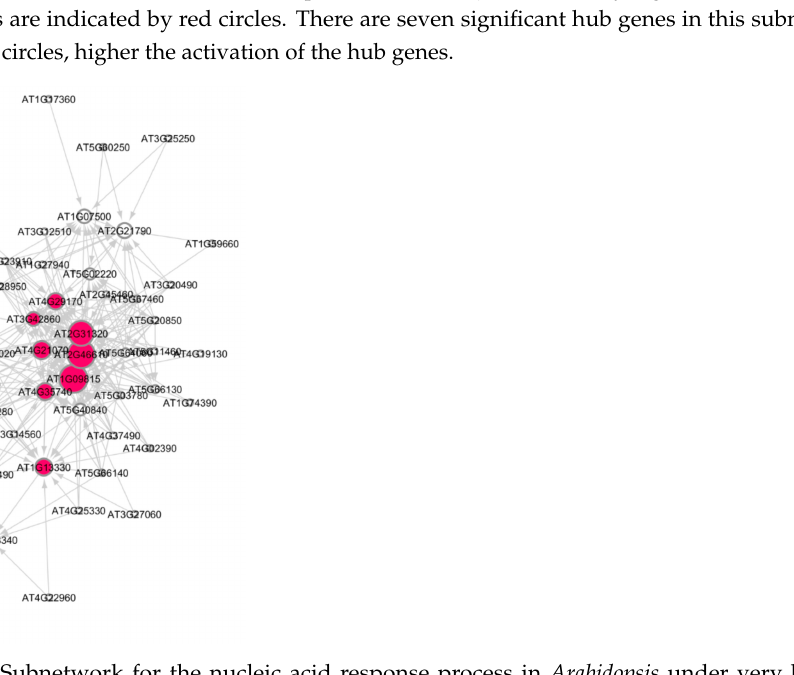
Figure 6. Subnetwork for the nucleic acid response process in Arabidopsis under very high γ R radiation. Red circles are hub genes. There are nine significant hub genes in this subnetwork. Larger the circles, higher the activation of the hub